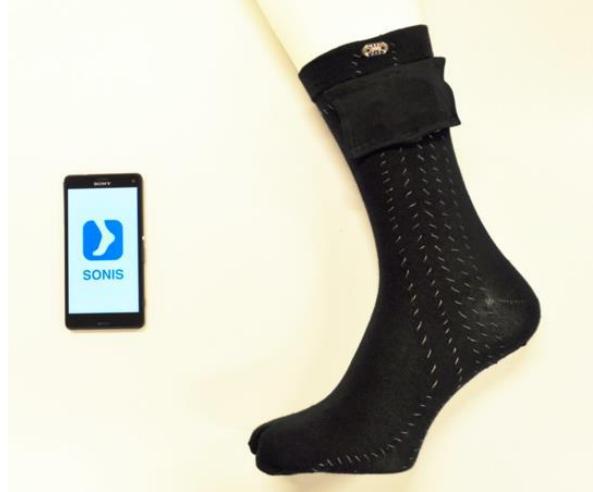
Figure 1. The SONIS system consists of smart rehabilitation socks and a smartphone application.